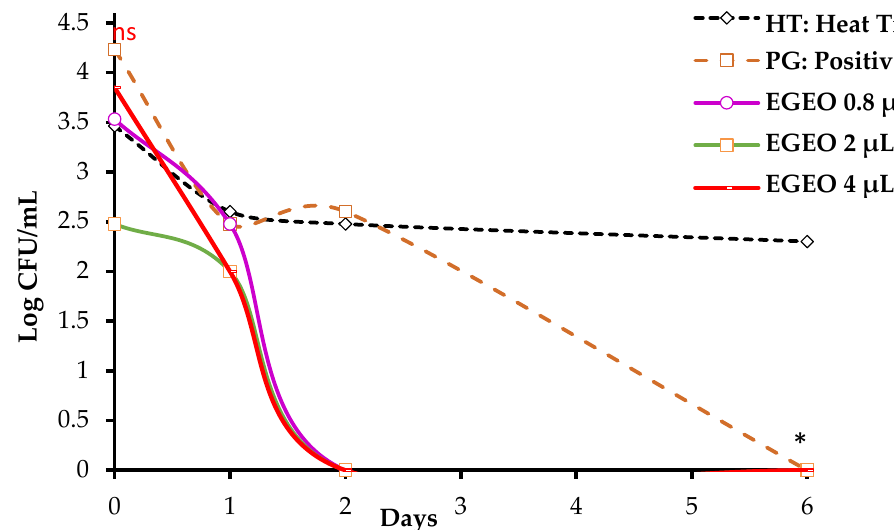
Figure 3. Effect of EGEO at different doses (0.08, 0.2 and 0.4 µL/mL) in association with moderate heat processing ( 70 °C for 2 min) on the viability of Saccharomyces cerevisiae cells in Orangina beverage during storage. The fungal growth was followed up to 6 days after the heat processing. HT: Heat treatment at 70 °C for 2 min; PG: Positive control or juice with synthetic antimicrobial additives (sodium benzoate and potassium sorbate); EGEO: Eucalyptus globulus essential oil; CFU: Colony-forming unit. * significant difference ( p < 0.05) according to ANOVA one-way analysis followed by Tukey’s post hoc multiple comparison tests.